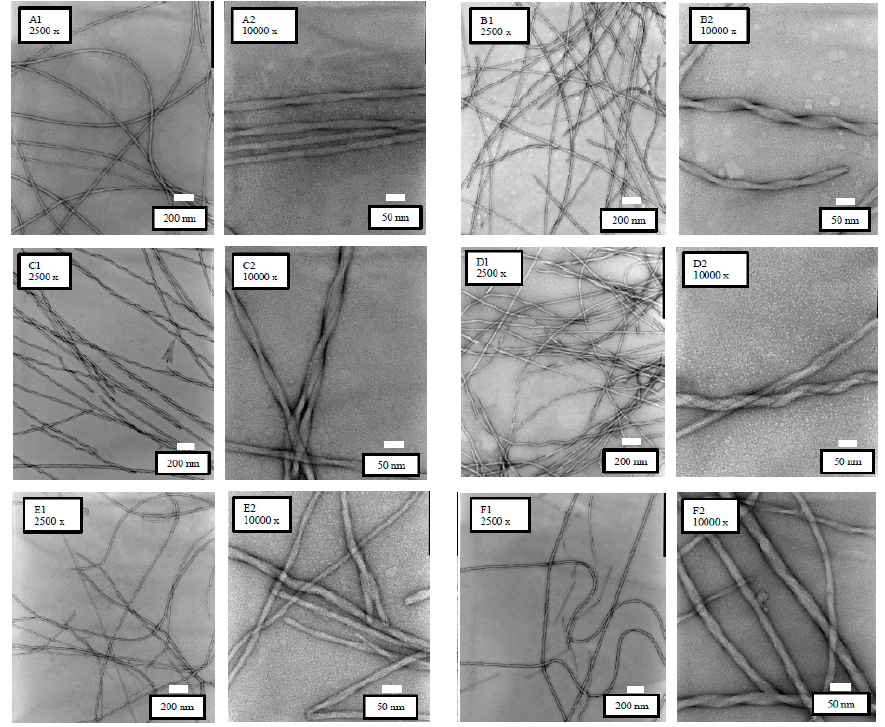
Figure 7. TEM observation results of the Pal-GH gel formulations at different magnifications (×2500 and ×10,000). F5 MTZ (A1,A2), F5 IPM-MTZ (B1,B2), F5 PG-MTZ (C1,C2), F5 DMSO-MTZ (D1,D2), F5 EtOH-MTZ